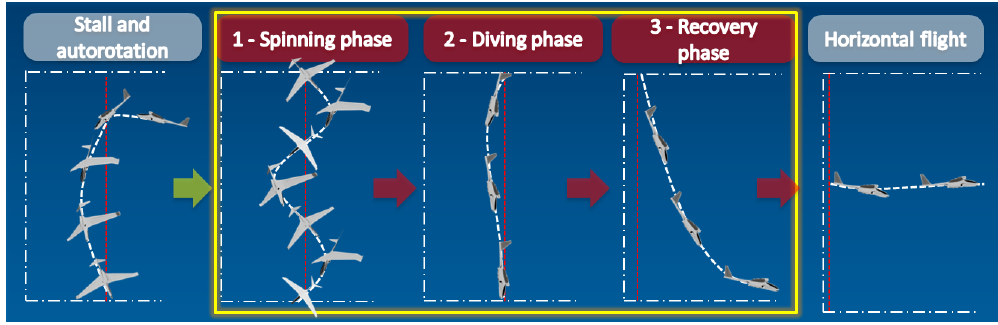
Figure 1. Phases of flight during spin